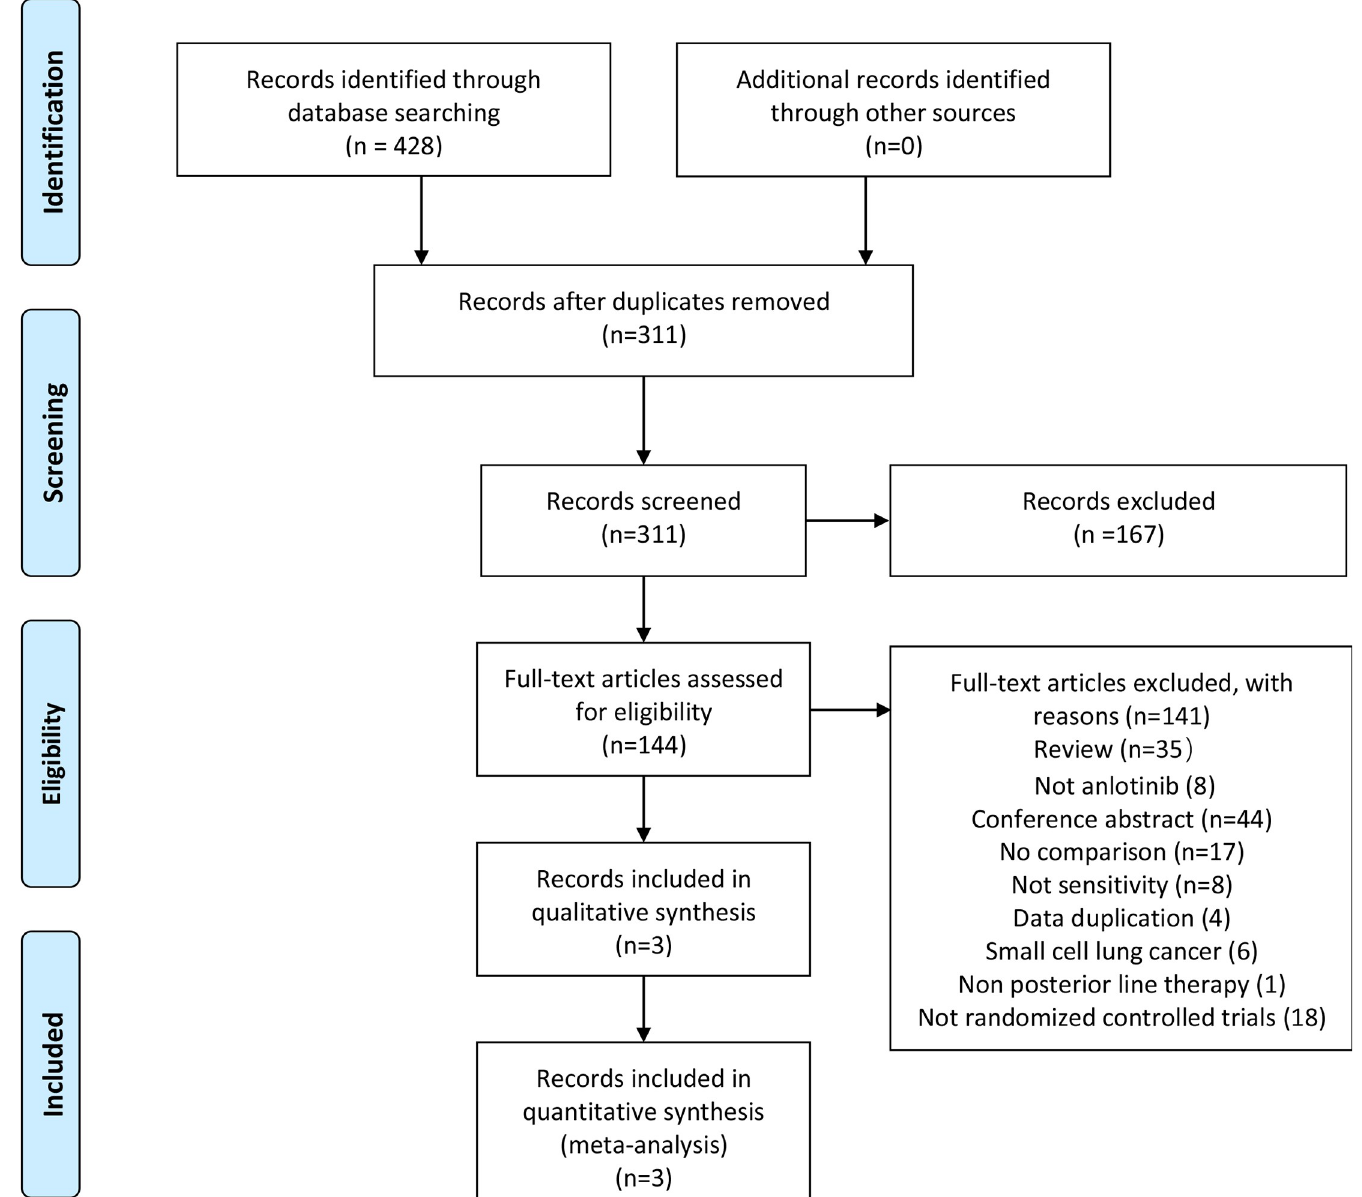
Fig 1. Diagram of the literature search and trial selection process in the meta-analysis. 57, 128, 49, 97, and 97 articles were found in PubMed, the Cochrane Library, Embase, CNKI, and Wanfang database, respectively.